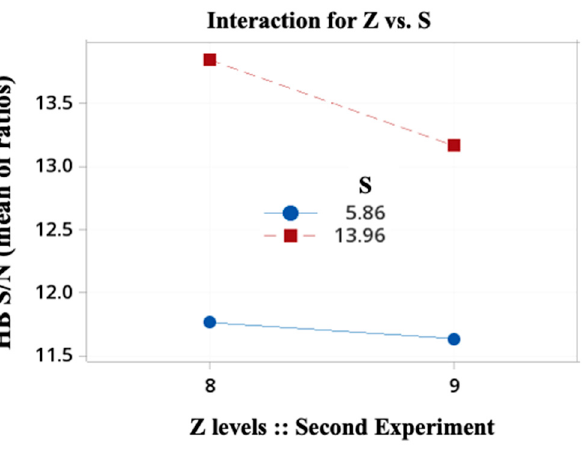
Figure 11. Interaction plot between Z and S for the second Taguchi experiment (see Table 5).